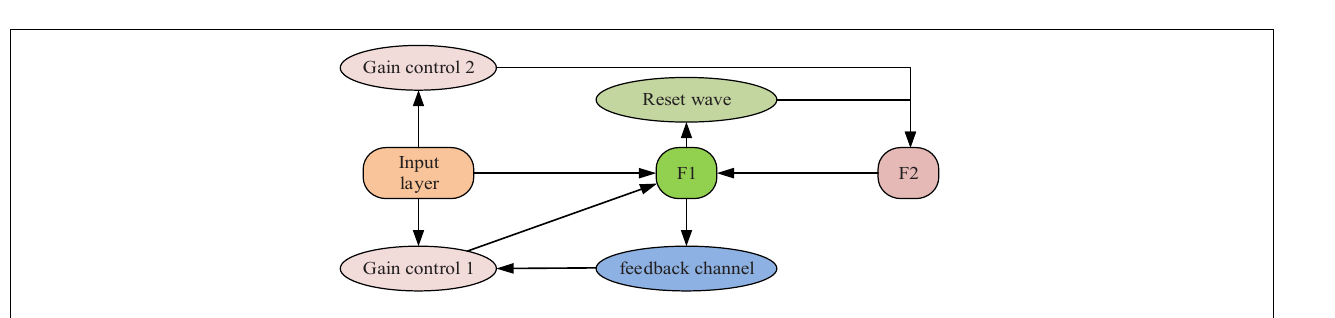
FIGURE 3 | Structure of the ART-BP